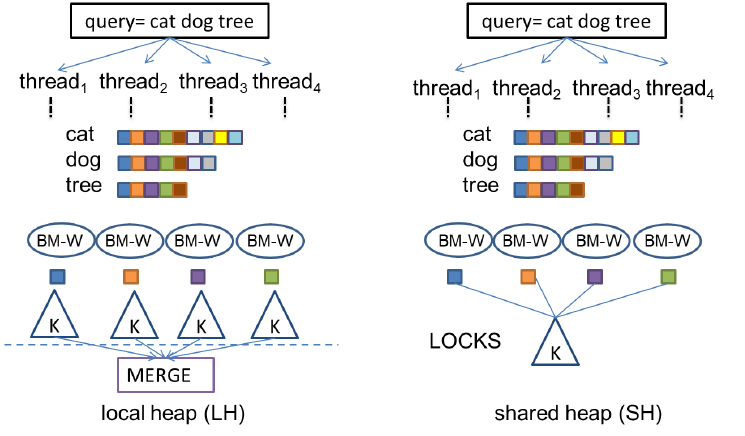
Figure 5. At left side is the LBM-WAND strategy. At right side is the SBM-WAND strategy where all threads share a global